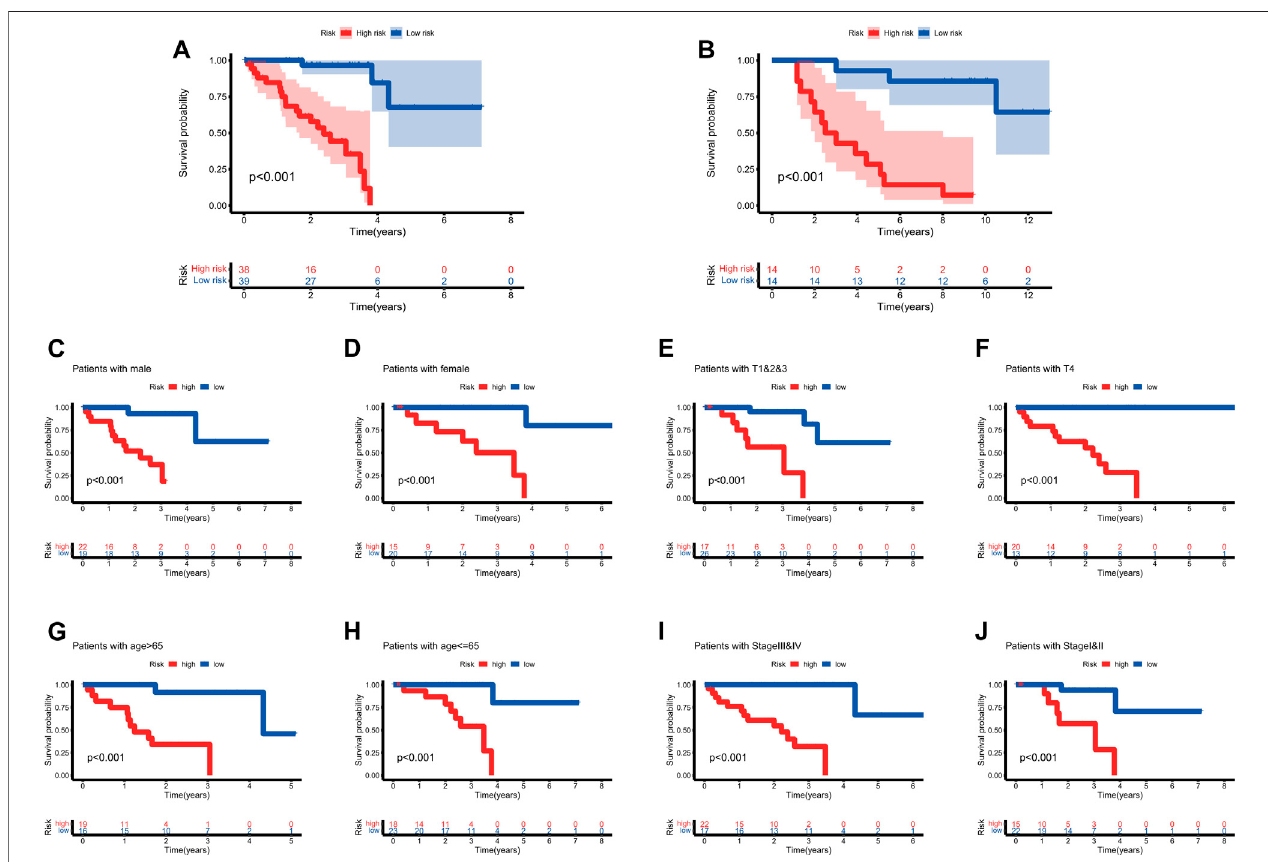
FIGURE3| Thesurvivalanalysisbasedon theprognostic model. (A,B) Tofurther testthecon fi denceoftheriskmodel, asurvivalanalysiswasperformedbetween high-risk group and low risk groups between the training cohort ( Figure 3A ) and the validation cohort ( Figure 3B ). (C – J) The survival rate of patients in the high-risk group suffered a more drastic decrease, regardless of the age, gender, and tumor stages. The differences were statistically signi fi cant ( p < 0.001).